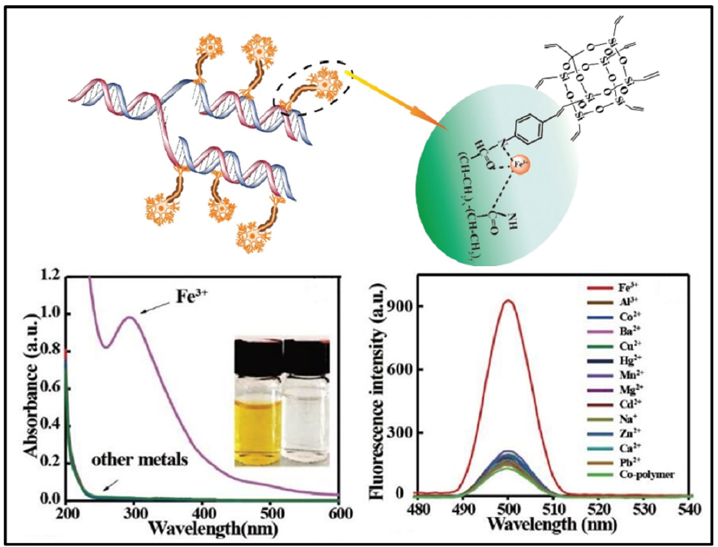
Figure 17. Schematic of the proposed bonding mode between OV-POSS co-poly (acrylamide) and